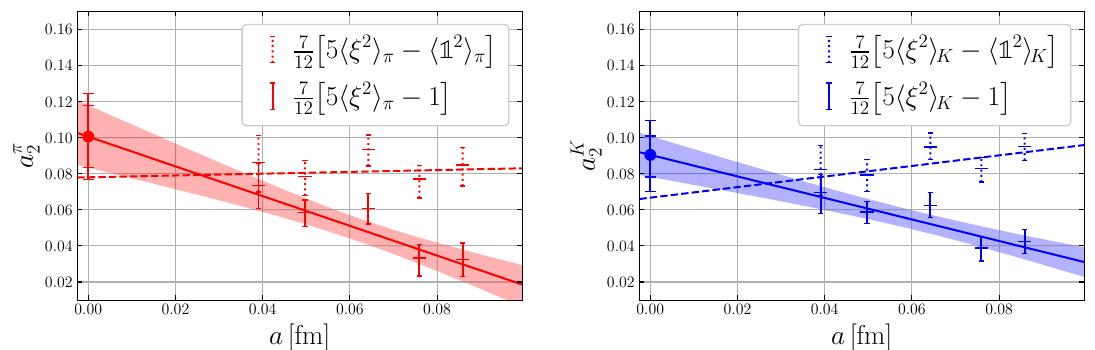
Figure 8 . Illustration of a different approach to quantify the discretization effect uncertainty . Instead of performing an alternative fit to the same data set (as in figure 7) one could per- for a M 2 form the same fit to an alternative data set. The points shown have been obtained by translating all data along the fitted functions (keeping the lattice spacing fixed) and then averaging measurements with the same a . In this picture, the solid lines and shaded bands represent the central values and statistical errors. The dashed lines correspond to the mean value of the fit to the alternative data points and the difference between solid and dashed lines could be used to estimate the systematic uncertainty due to the continuum extrapolation. (To avoid misunderstanding: the error estimates shown in this figure are not used in our determination of the moments of meson LCDAs.) For comparison we plot our final values for a π and a K as points at a = 0, where the inner error bars 2 2 are statistical only and the outer correspond to all errors added in